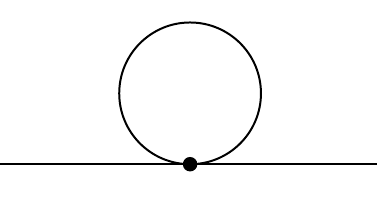
Figure 1 . Bubble diagram.